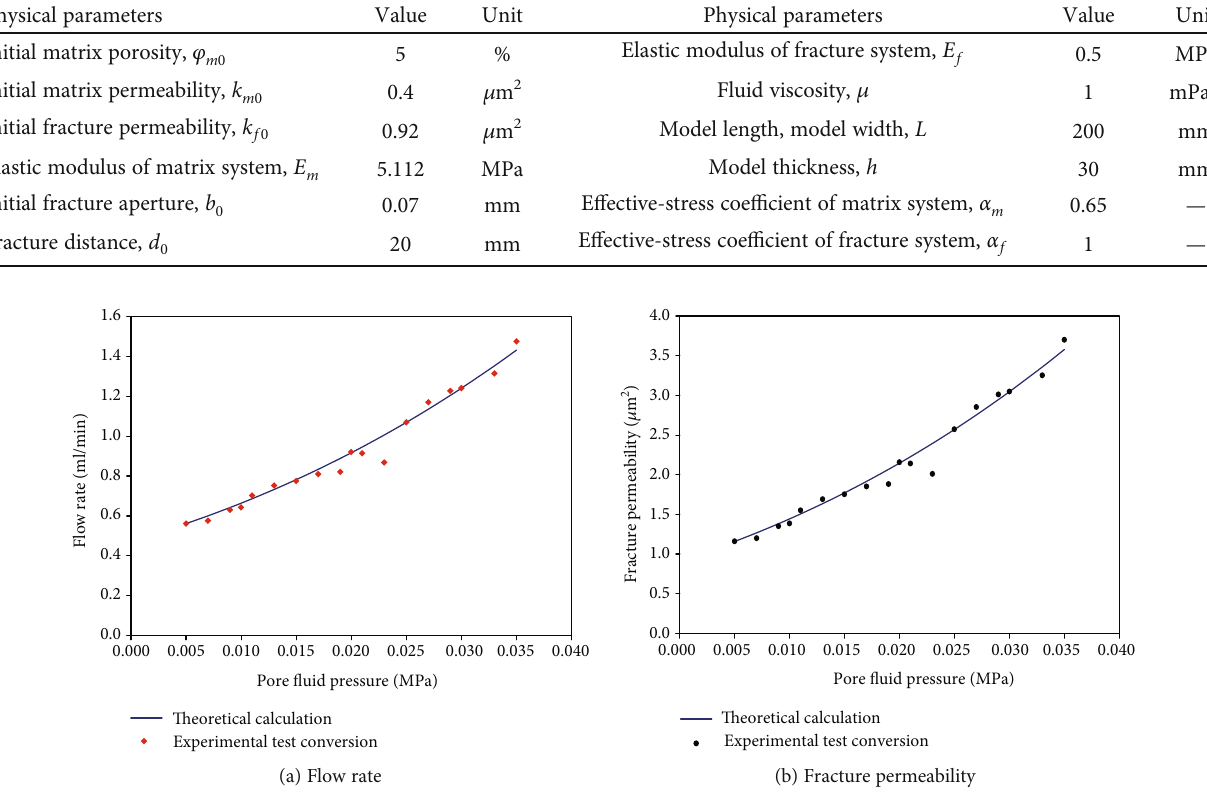
Figure 11: Comparison between experimental and theoretical